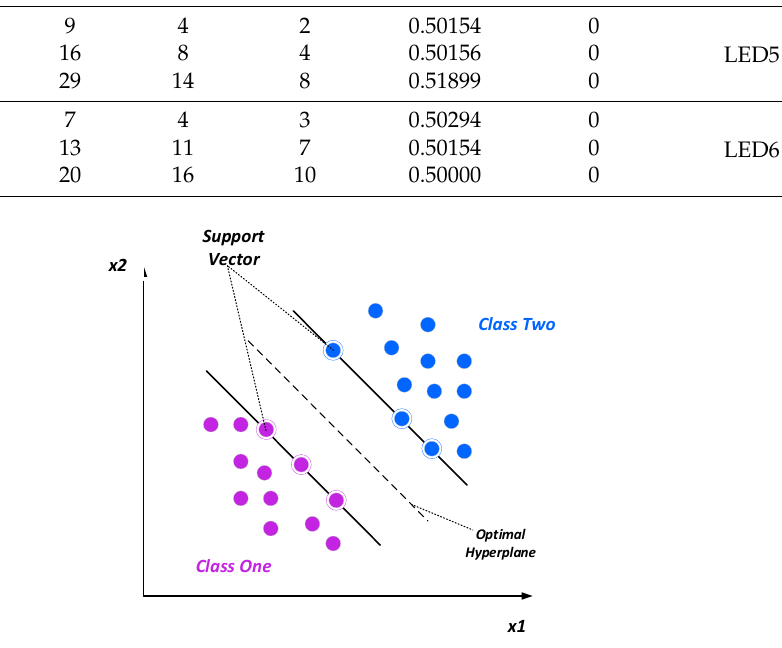
Figure 13. An example of a linearly separable two-class problem with two possible linear classifiers.